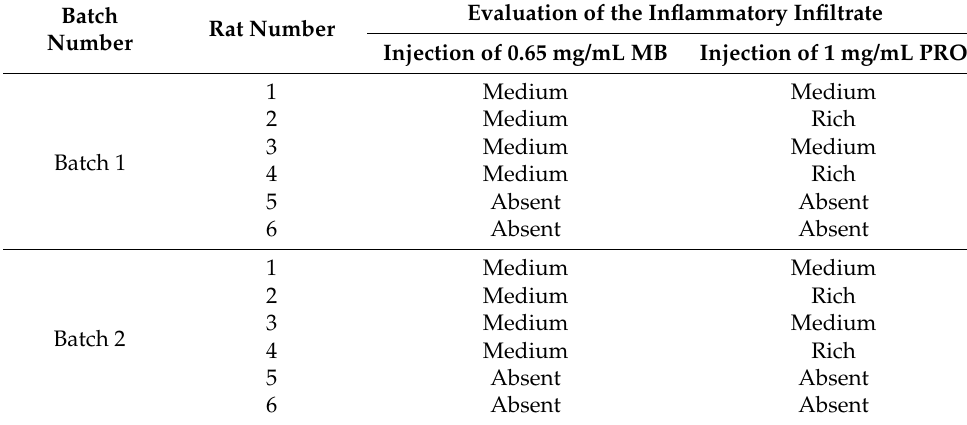
Table 1. Quantity of mixed inflammatory infiltrate in skin island after dye